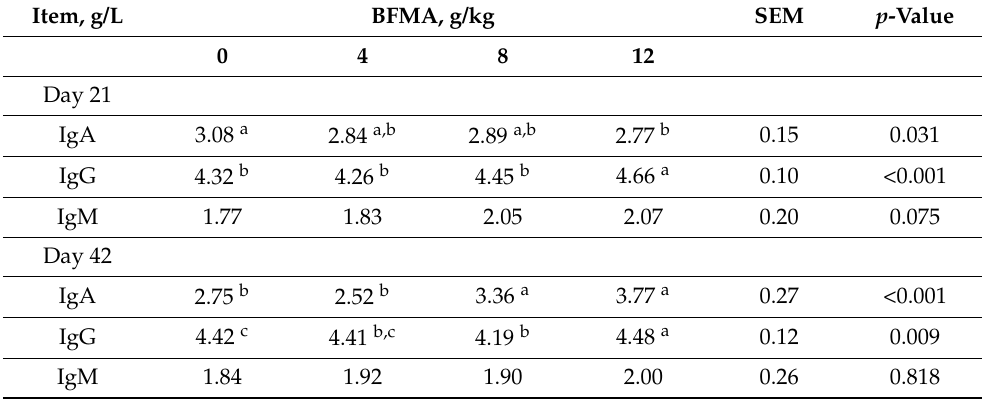
Table 5. Effects of dietary malic acid on serum immunity of broilers. Item, g/L